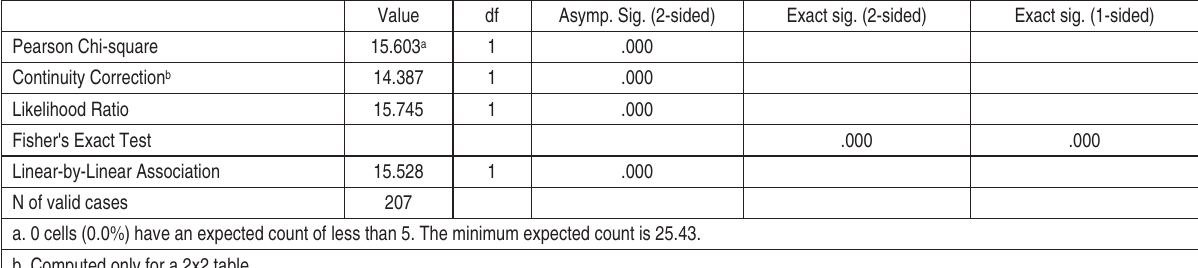
Table 1. Fisher’s Exact Test